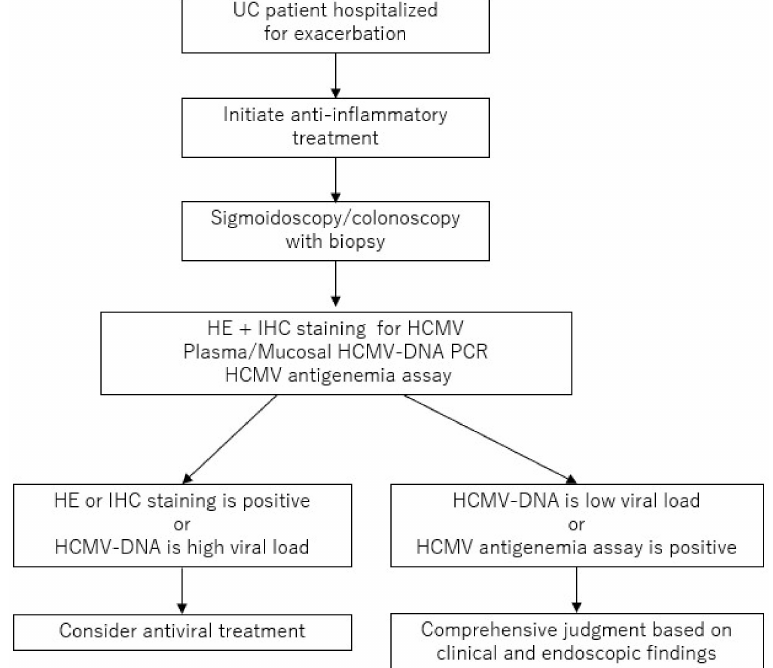
Figure 3. Proposed diagnostic and therapeutic strategy for the patients with ulcerative colitis and the patients with a suspected human cytomegalovirus colitis. UC: ulcerative colitis, HE: hematoxylin and eosin, IHC: immunohistochemistry, HCMV: human cytomegalovirus, PCR: polymerase chain